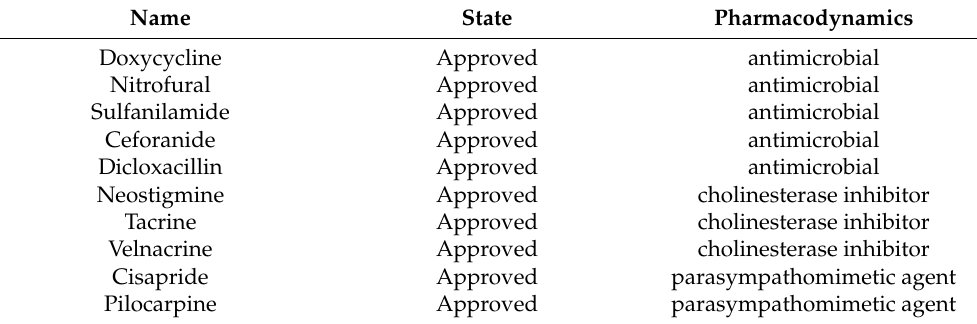
Table 1. The agent information of group